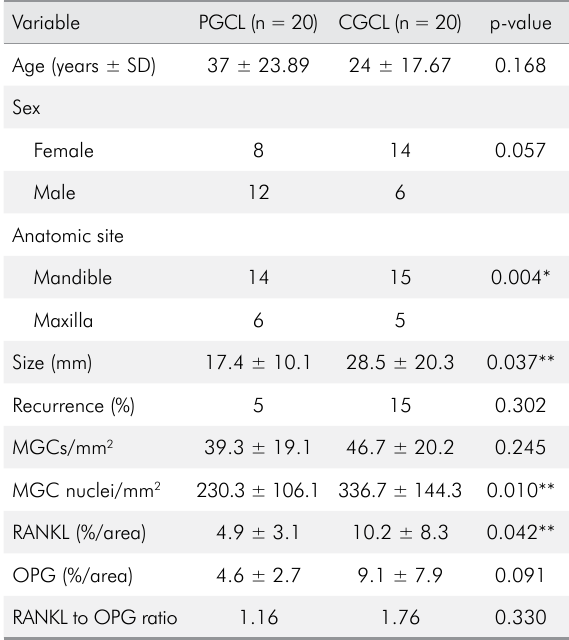
Table 1. Clinical, microscopic, and immunohistochemical findings in patients with central and peripheral giant cell